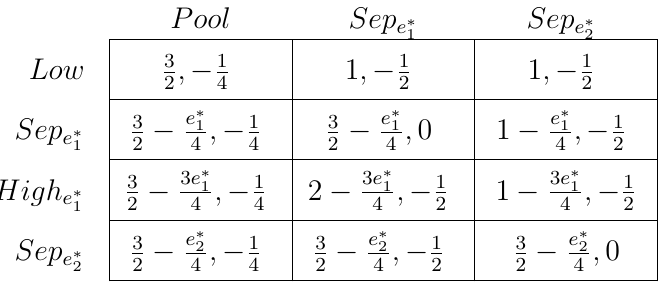
Table 2. The expanded pruned Spence signaling game with p